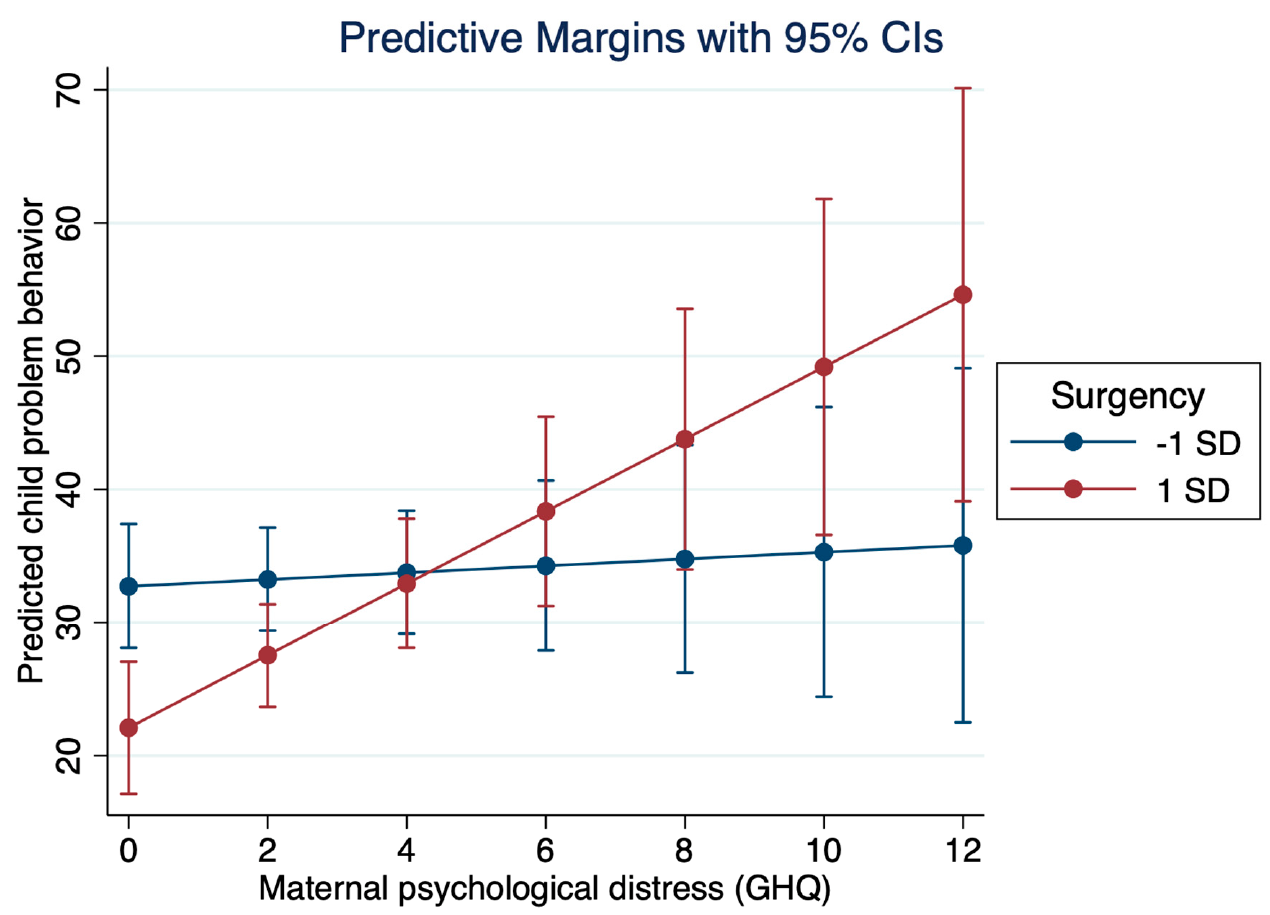
Figure 1. Interaction of child problem behavior and maternal psychological distress. Last, in a multivariate model, the associations between child and maternal tempera- mental characteristics and maternal distress with child problem behaviors were examined (Table 7). The results of these analyses showed that child negative affect was consistently associated with child problem behaviors. The interaction term between adoption status and the independent variables (child and maternal temperamental characteristics and maternal distress) was not statistically significant ( p -values > 0.05) suggesting that the